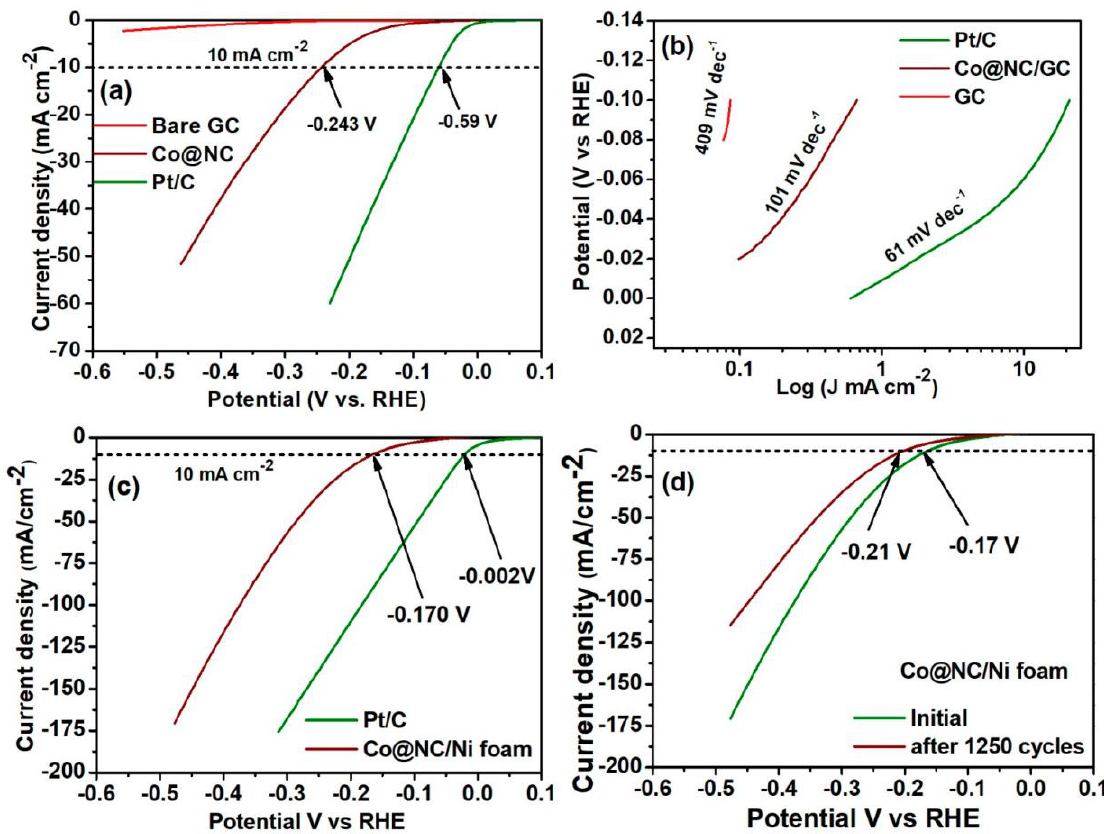
Figure 5. Hydrogen evolution reaction (HER) LSVs measured at 5 mV · s − 1 in 1.0 M KOH solution of Co@NC and commercial 20% Pt/C catalysts in ( a ) glassy carbon electrode ( b ) Ni foam. ( c ) the corresponding Tafel plots derived from data of ( a ). ( d ) LSVs recorded before and after 1250 cycles using the Co@NC/Ni foam catalyst.